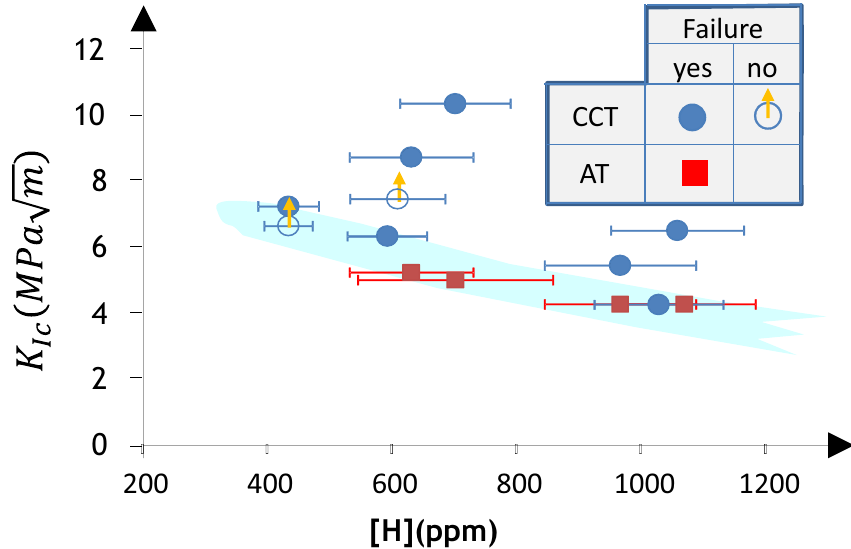
Fig. 8. In fl uence of sample hydrogen content on the evaluated cladding fracture